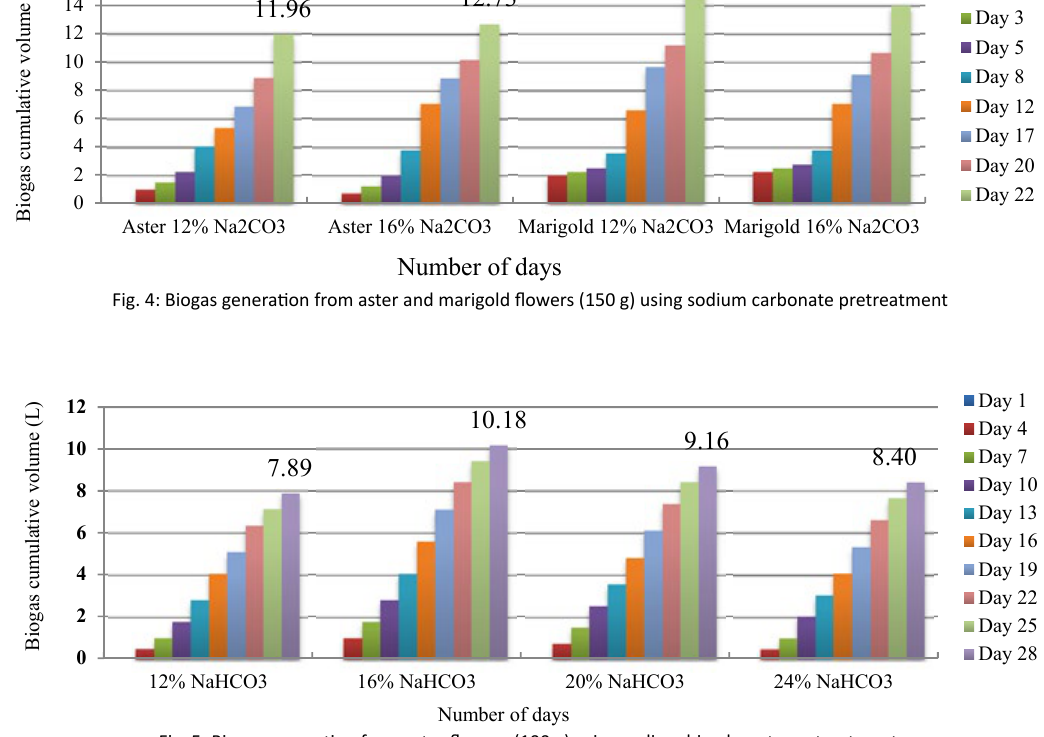
Fig. 5: Biogas generation from aster flowers (100 g) using sodium bicarbonate pretreatment